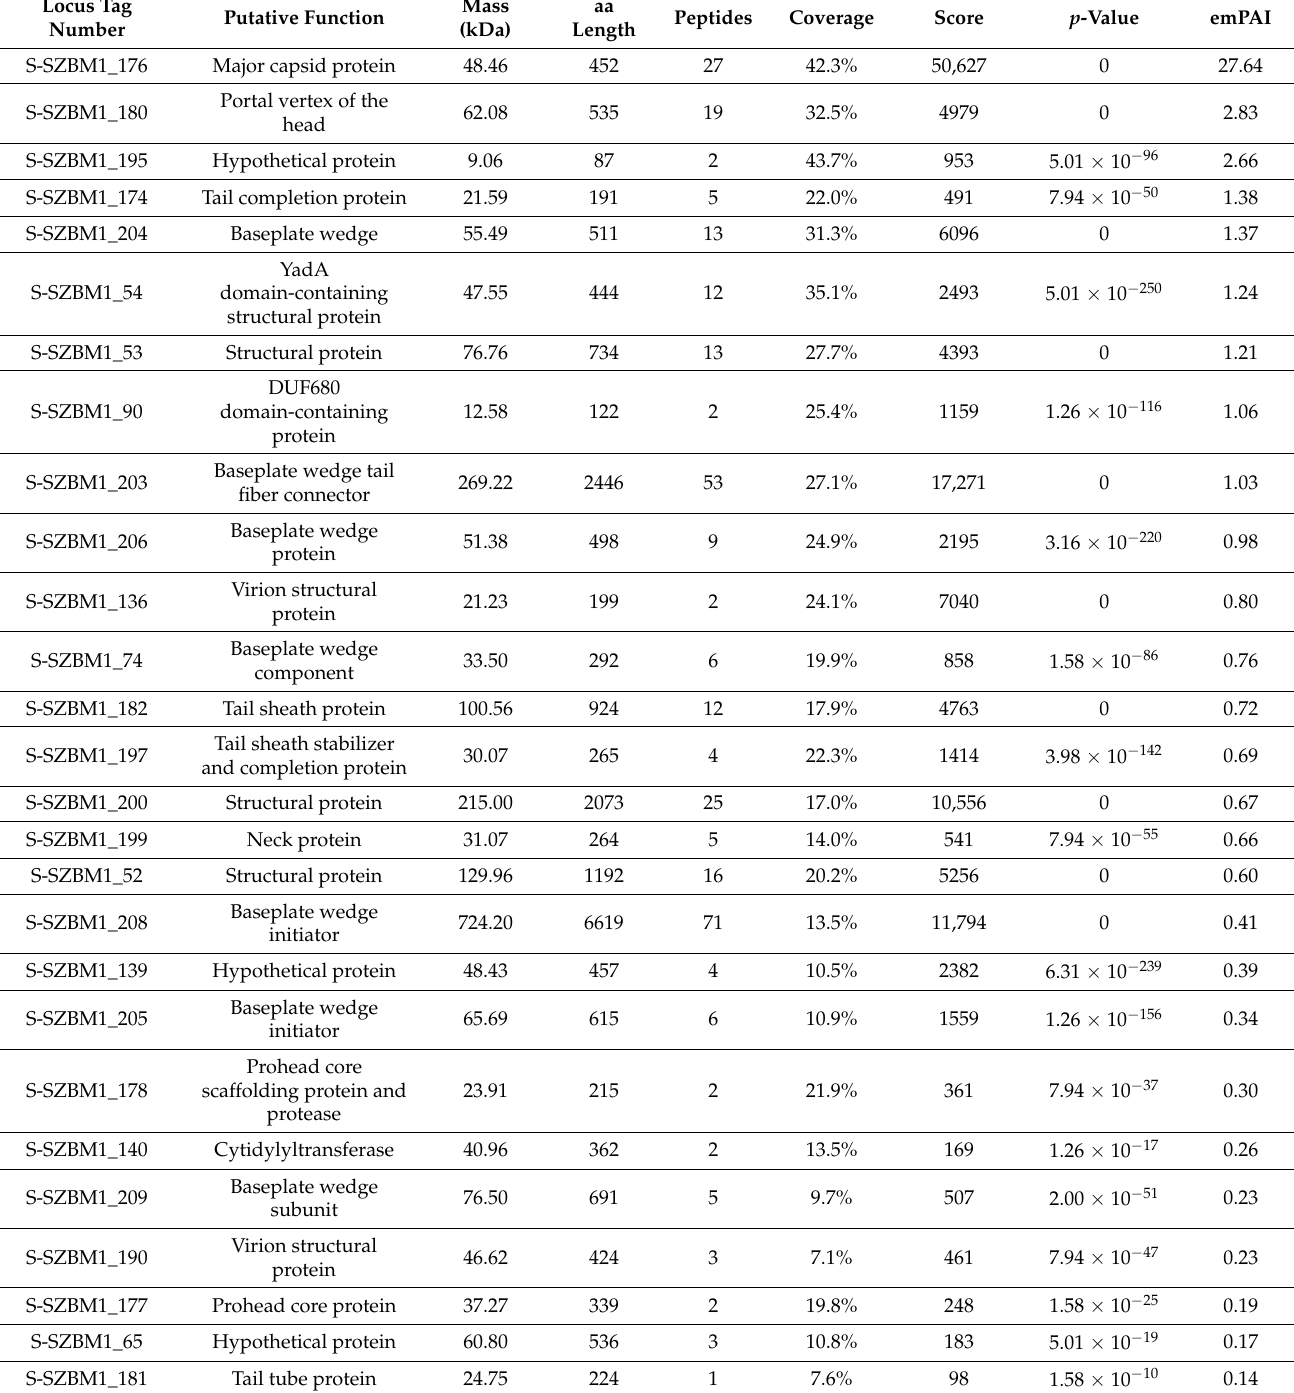
Table 1. Confirmed proteins encoded by genes in cyanophage S-SZBM1 (score >